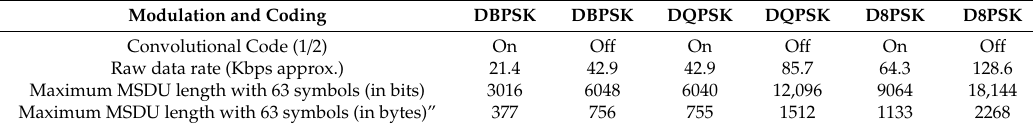
Table 2. PHY data rate and packet size parameters, for various modulation and coding schemes.